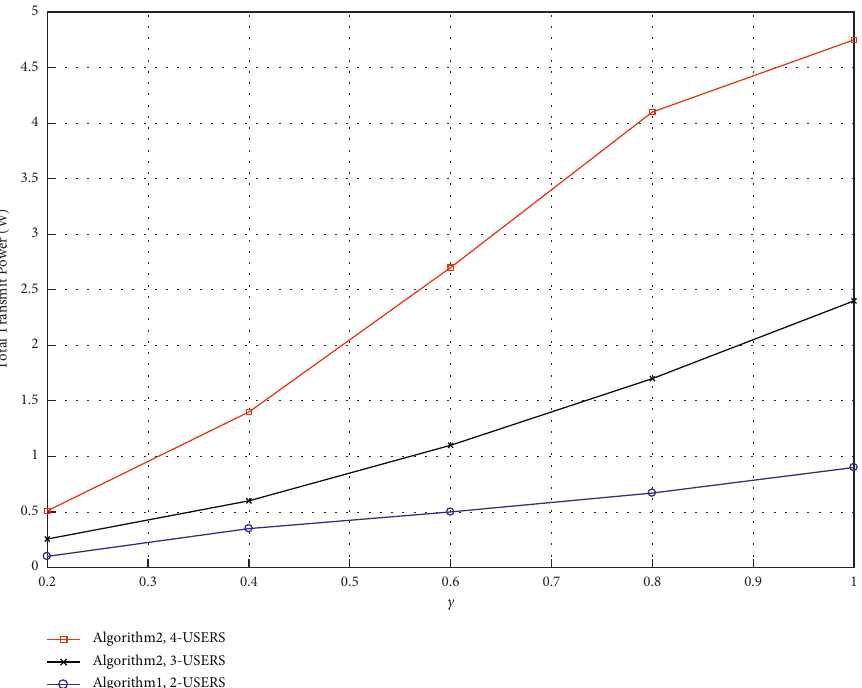
Figure 7: The optimal total transmission power versus the value of SINR, with c � 1, K � 20, and η �